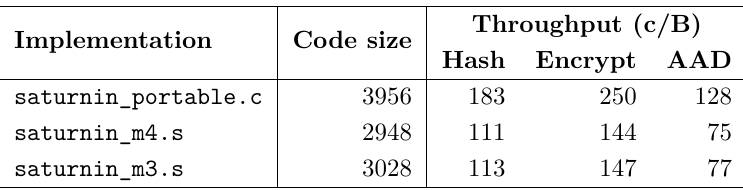
Figure 16: Size and performance of streamable implementations of Saturnin -CTR- Cascade and Saturnin -Hash on ARM Cortex-M4. The code size is expressed in bytes; the processing speeds for hashing, encryption, and additional authenticated data, are given in